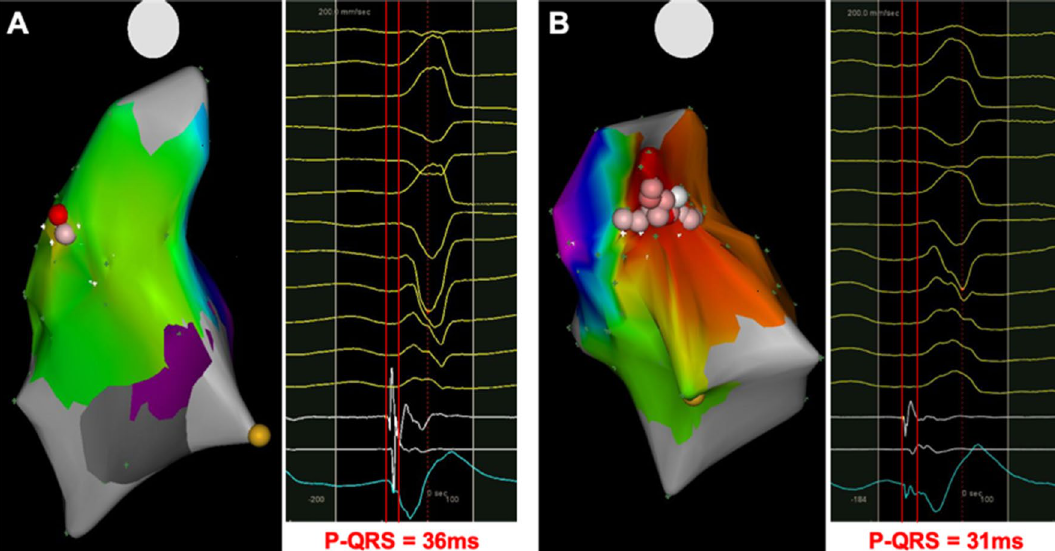
Figure 4. Examples of successful ablation below the PV in VAs with ( A ) or without ( B ) special potential. In each figure, the left panel shows the CARTO activation map of a PVC in the posterior–anterior view, while the local electrogram at the initial ablation site is shown in the right panel.